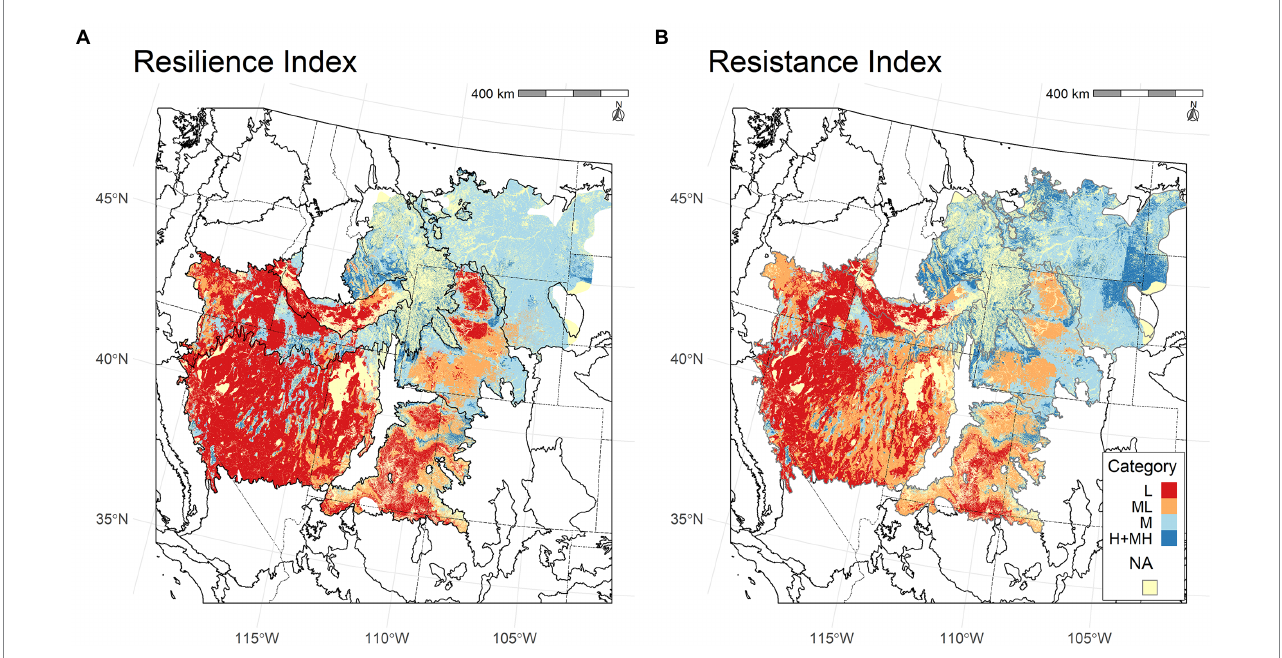
FIGURE 7 Maps of predicted (A) resilience and (B) resistance for the study area with Level III EPA ecoregions and states delineated (US Environmental Protection Agency [US EPA], 2022). Areas that do not support the focal ecosystems are shown in light yellow (“NA”).